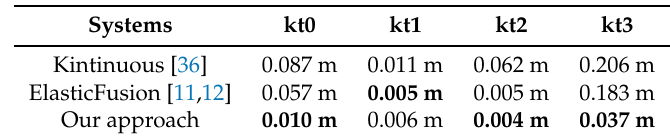
Table 4. Comparison of reconstruction accuracy results on the ICL-NUIM datasets [50]. We measure the mean distance from each point of the produced dense surface to the nearest surface point in the ground truth 3D